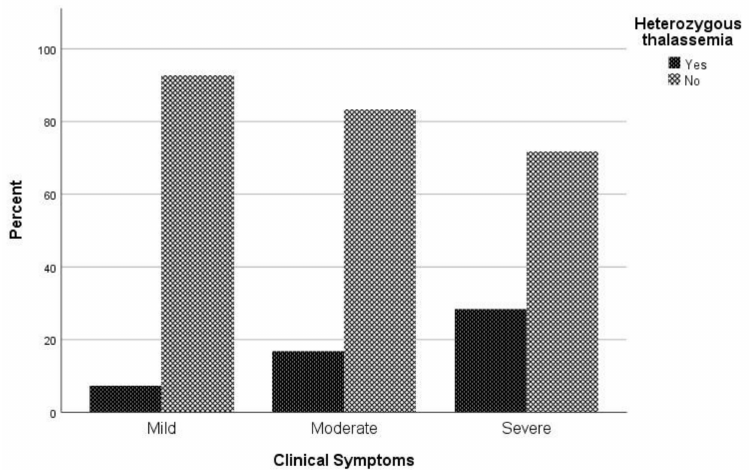
Figure 1. Proportion of β -thalassemia heterozygotes relative to non-carriers regarding clinical symptoms to